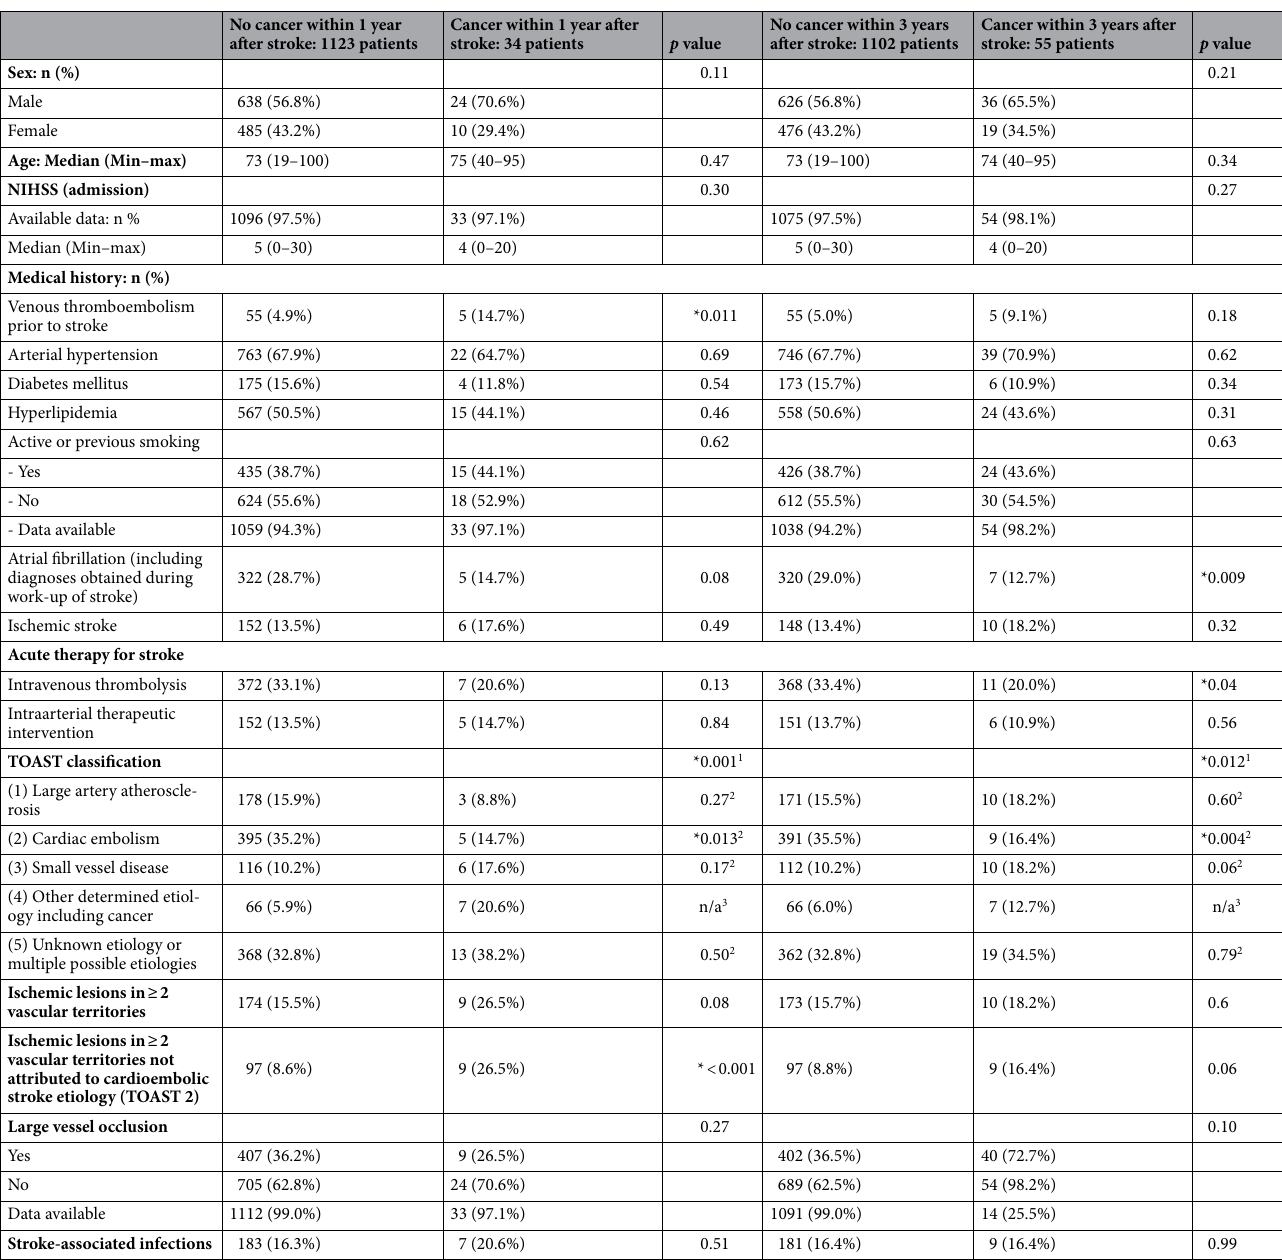
Table 2. Patient characteristics. 1 Group comparison, 2 Single comparisons, 3 Analysis